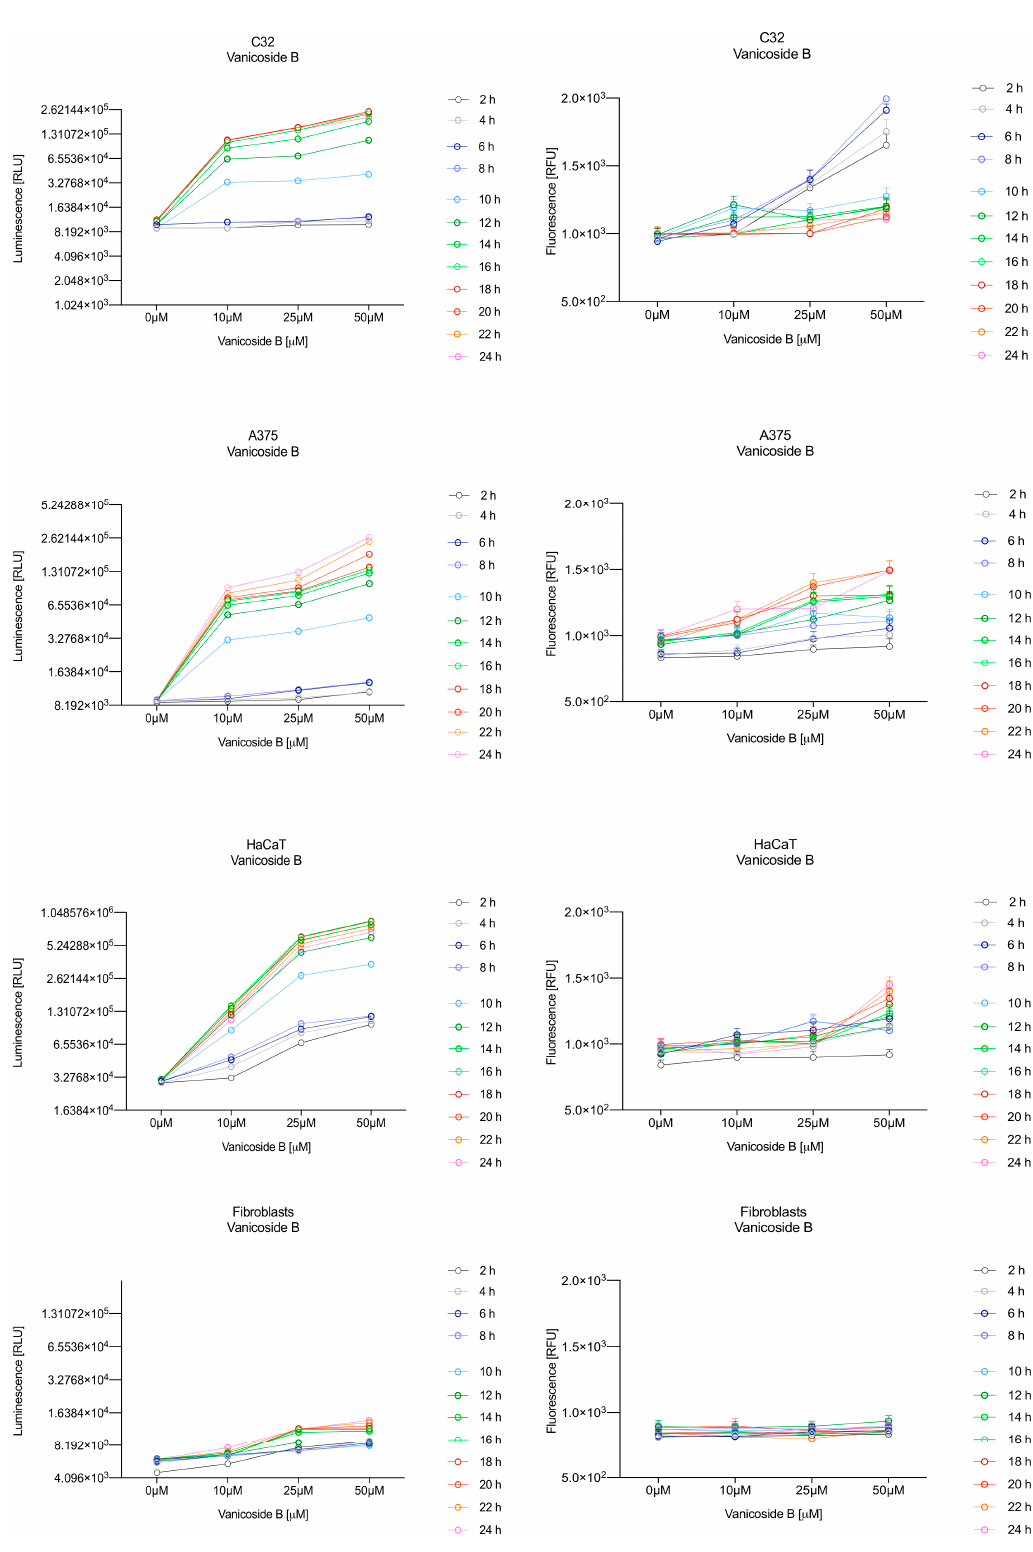
Figure 4. Repeated measurements of luminescence and fluorescence signals. C32, A375, HaCaT and fibroblast cell lines were exposed to serial dilutions of vanicoside B in the presence of RealTime-GloTM Annexin V Apoptosis and Necrosis Assay reagent. RLU (left panels, PS: annexin V binding) and RFU (right panels; membrane integrity) were collected at indicated times. Data represent the mean of 3 readings for each replicate ± SD .